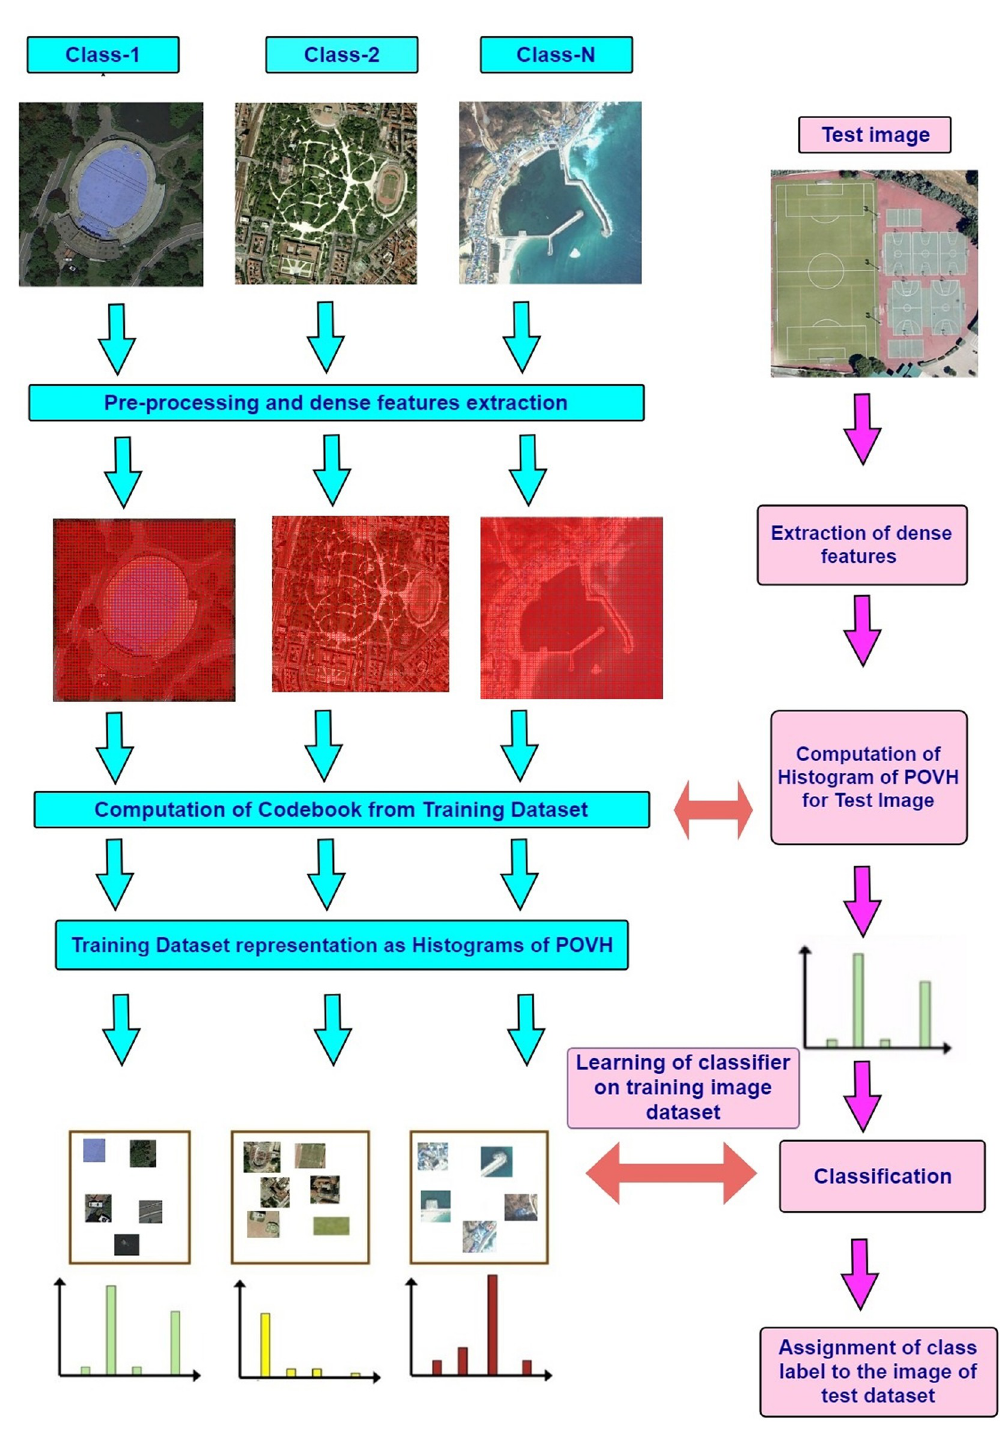
Fig 4. Block diagram of the proposed research